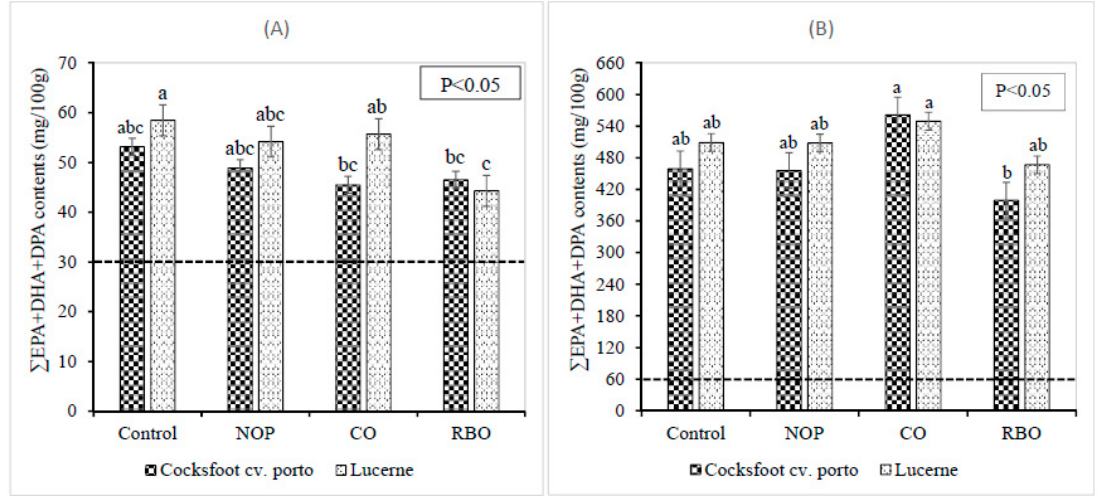
Figure 1. Effect of pellet supplementation on the contents of ∑ EPA + DPA + DHA (EPA, eicosapentaenoic acid; DHA, docosahexaenoic acid; DPA, docosapentaenoic acid) in Longissimus dorsi muscle ( A ) and liver ( B ) of grazing lambs. Control: grazing on cocksfoot cv. porto or lucerne pastures only as basal pastures; NOP: basal pastures plus no oil pellets; CO: basal pastures plus canola oil infused pellets; RBO: basal pastures plus rice bran oil infused pellets. Different letters (a, b, c) indicate significant differences between treatments ( p < 0.05).